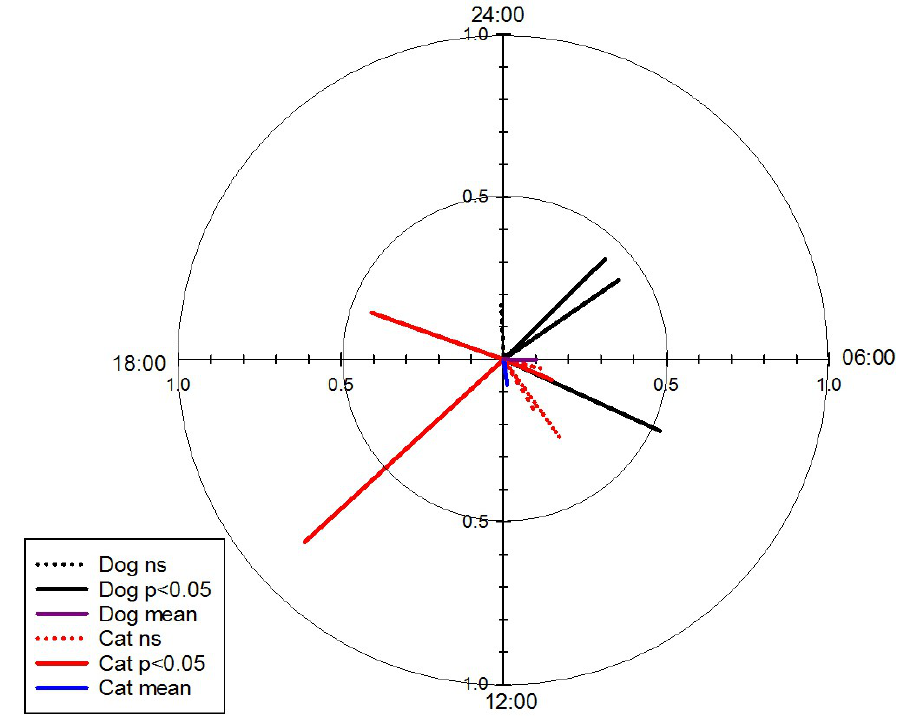
Figure 4. Circular plot of the activity vectors of: all collared cats (red) and the mean cat vector (blue), all collared dogs (black) and the mean dog vector (purple) and the dogs captured on camera traps (green). Solid lines indicate a significant value ( p < 0.05) whilst dotted lines indicant a nonsignificant value.